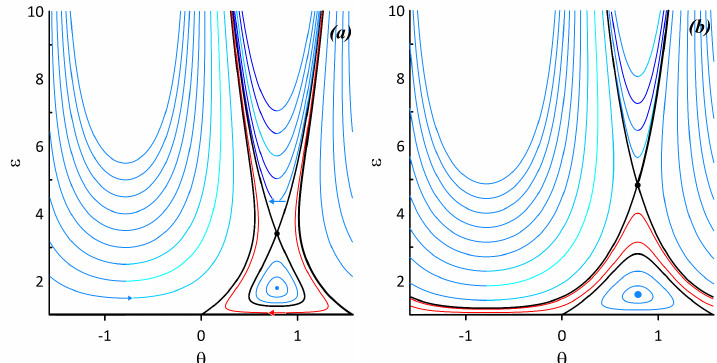
Figure 14. Phase portraits of the ellipsoid vortex motion corresponding to Regimes: ( a ) 5 ( e = 0.09 and γ = − 0.07); and ( b ) 7 ( e = 0.09 and γ = −